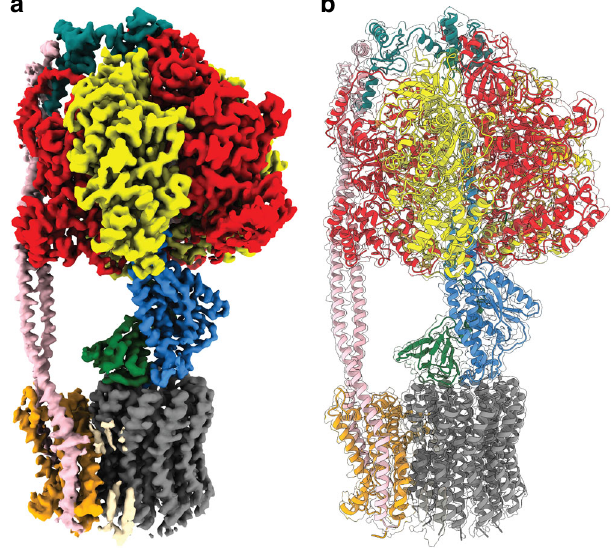
Fig. 1 Cryo-EM map and atomic model of E. coli F 1 F o ATP synthase. Subunit α in red, β in yellow, δ in teal, ε in green, γ in blue, a in orange, b in pink, c in gray and potential lipids in wheat. Very weak density likely corresponding to detergent was removed for clarity. a Cryo-EM map shown as surface and ( b ) atomic model shown in transparent cryo-EM map. Sub- state 3A is